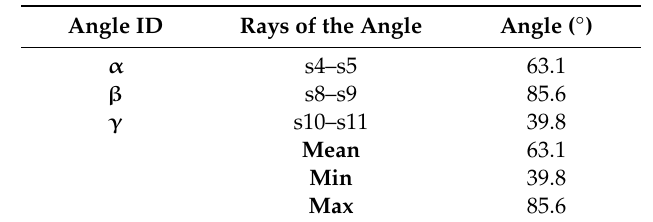
Table A3. Angle measures of the stick-like structures from Vera Rubin Ridge, Mars. See Figure A3 for location of